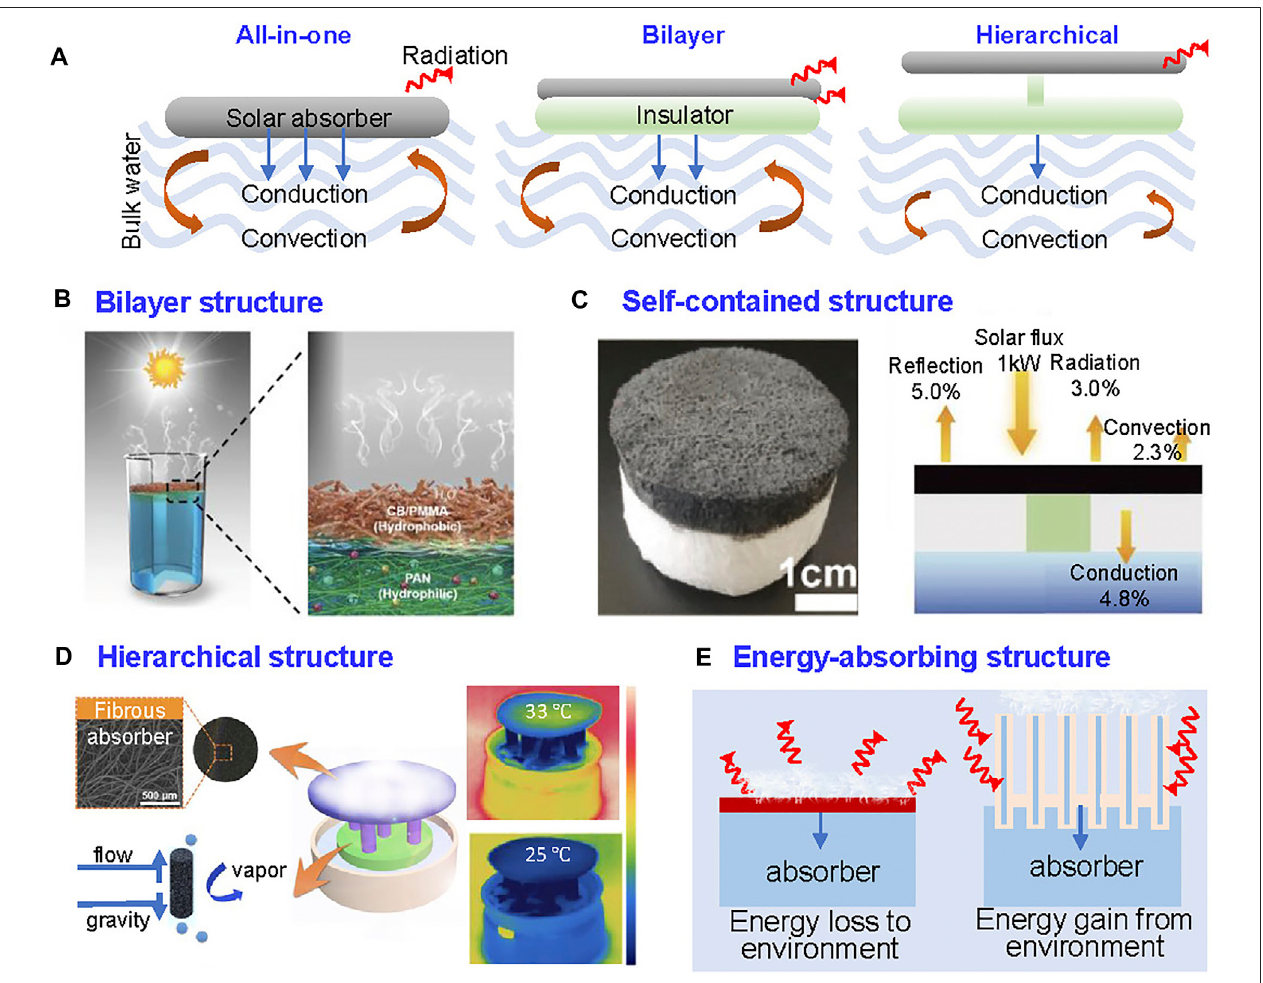
FIGURE 8 | Thermal management strategies of ef fi ciency enhancement of SVG. (A) Working principles of all-in-one, bilayer, and hierarchical structures of SVG system (Zhao et al., 2020). (B) Bilayer fi brous aerogels with top hydrophilic layer and bottom hydrophobic layer. Reprinted with permission from (Xu et al., 2018). Copyright(2018)WILEYVCH. (C) Structureoftheself-contained fi brousaerogelanditsoperationprinciple.Reprintedwithpermissionfrom(LiN.etal.,2021).Copyright (2020) WILEY VCH. (D) Structure of the hierarchical fi brous aerogel and its working performance. Reprinted with permission from (Yu Z. et al., 2019). Copyright (2018) American Chemical Society. (E) Working principles of the energy-absorbing SVG device by extending evaporator length (Li et al., 2018).